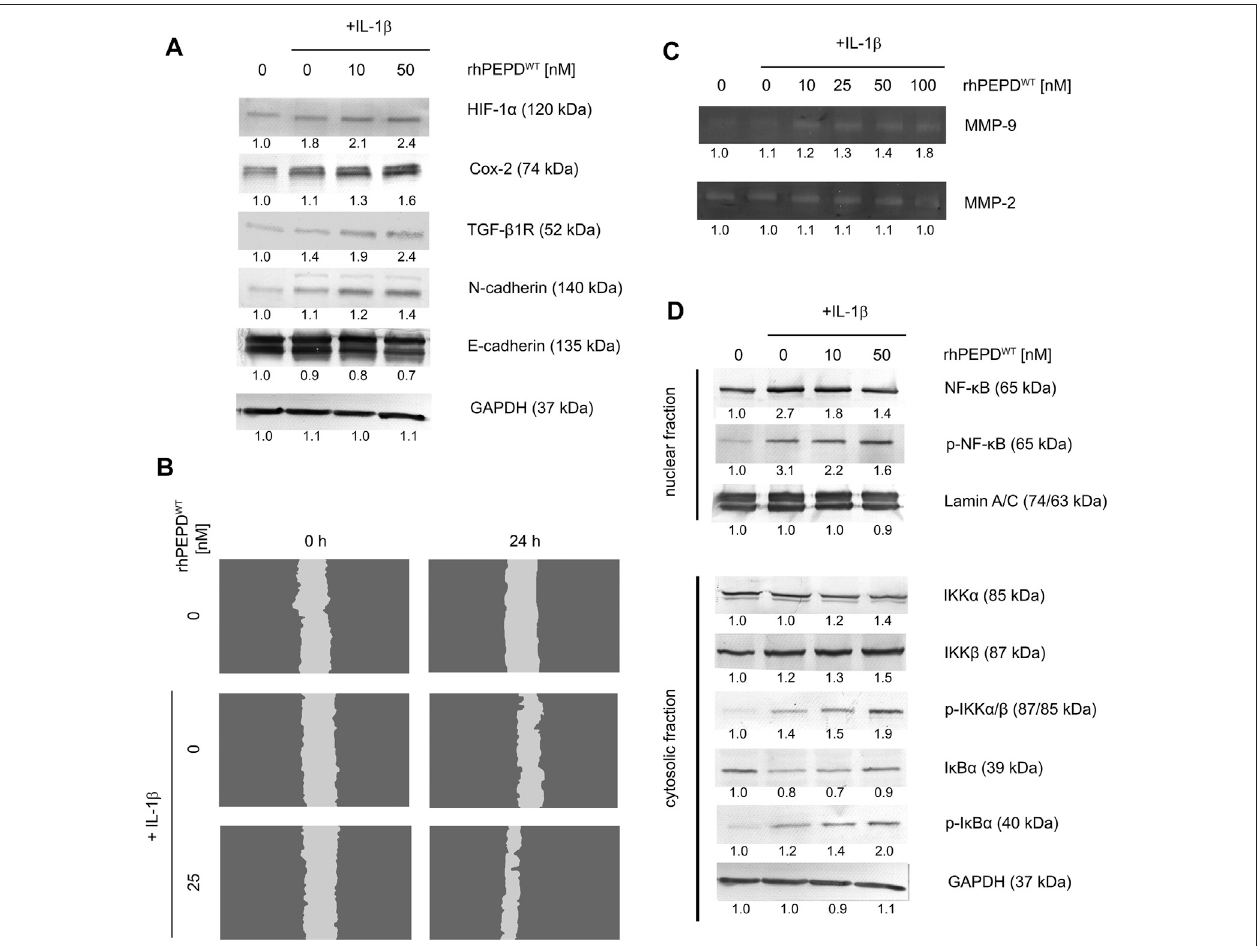
FIGURE3|(A) Westernimmunoblottingfortheproteins involvedin EMTinlysates ofrhPEPD-treated HaCaT cells(rhPEPD WT , 10,50 nM) and IL-1 β (10 ng/ml) for 24 h. GAPDH was used for normalization; (B) The effect of rhPEPD on HaCaT cell migration under conditions of IL-1 β -induced in fl ammation; (C) The activity of MMP-2 and-9inthecollectedculturemediafromHaCaTcellstreatedwithvariousrhPEPD WT concentrations(10,25,50,100 nM)andIL-1 β ; (D) Westernimmunoblottingforthe proteins of NF- κ B pathway activation in lysates of rhPEPD-treated HaCaT cells (rhPEPD WT , 10, 50 nM) for 30 min in the presence or absence of IL-1 β (10 ng/ml). GAPDH was used as a loading control. The data are presented as the mean ± SD, n = 3 in each group and compared to the control group. Representative blot images were shown (densitometry of protein stains is presented under protein bands as a ratio versus control; Supplementary Figure S1